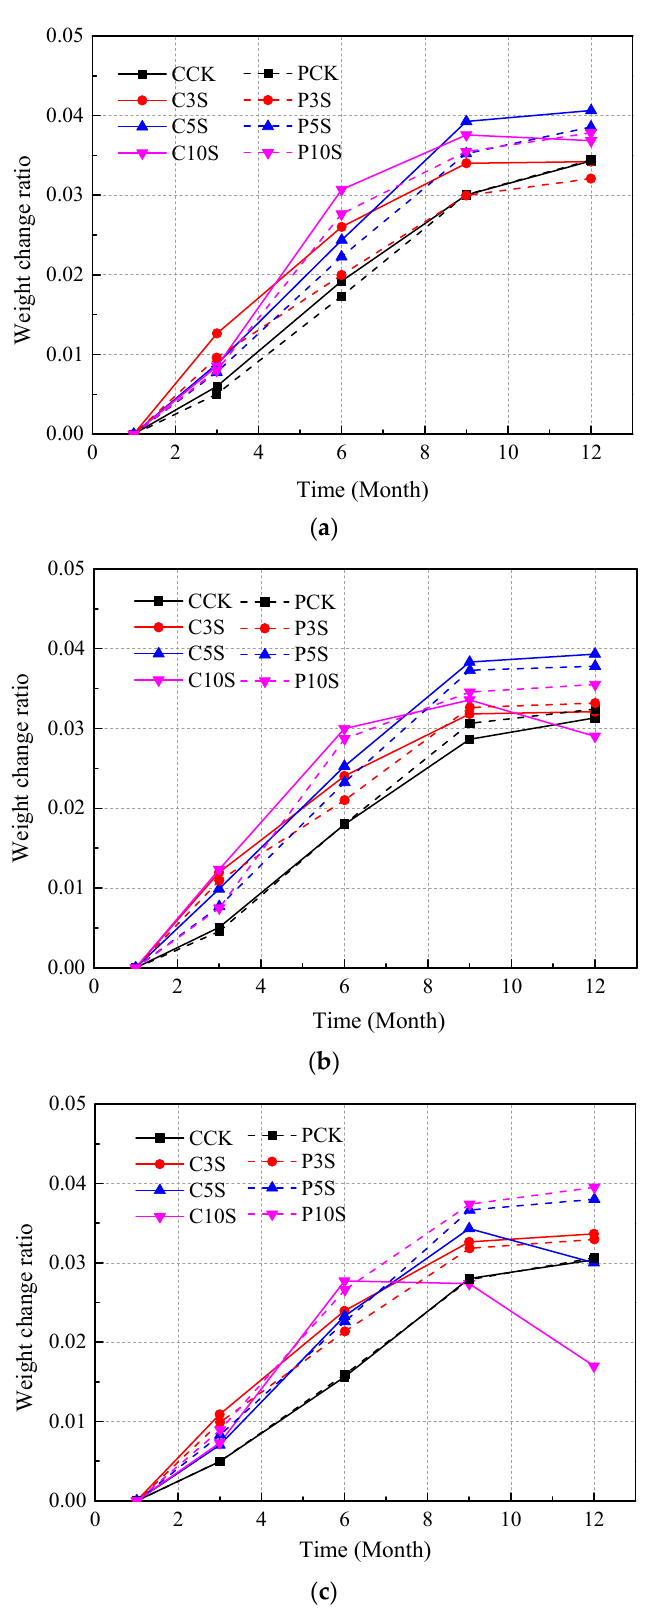
Figure 5. Weight change ratios for concrete with different water/cement ratios: ( a ) 0.40, ( b ) 0.48, and ( c ) 0.55.